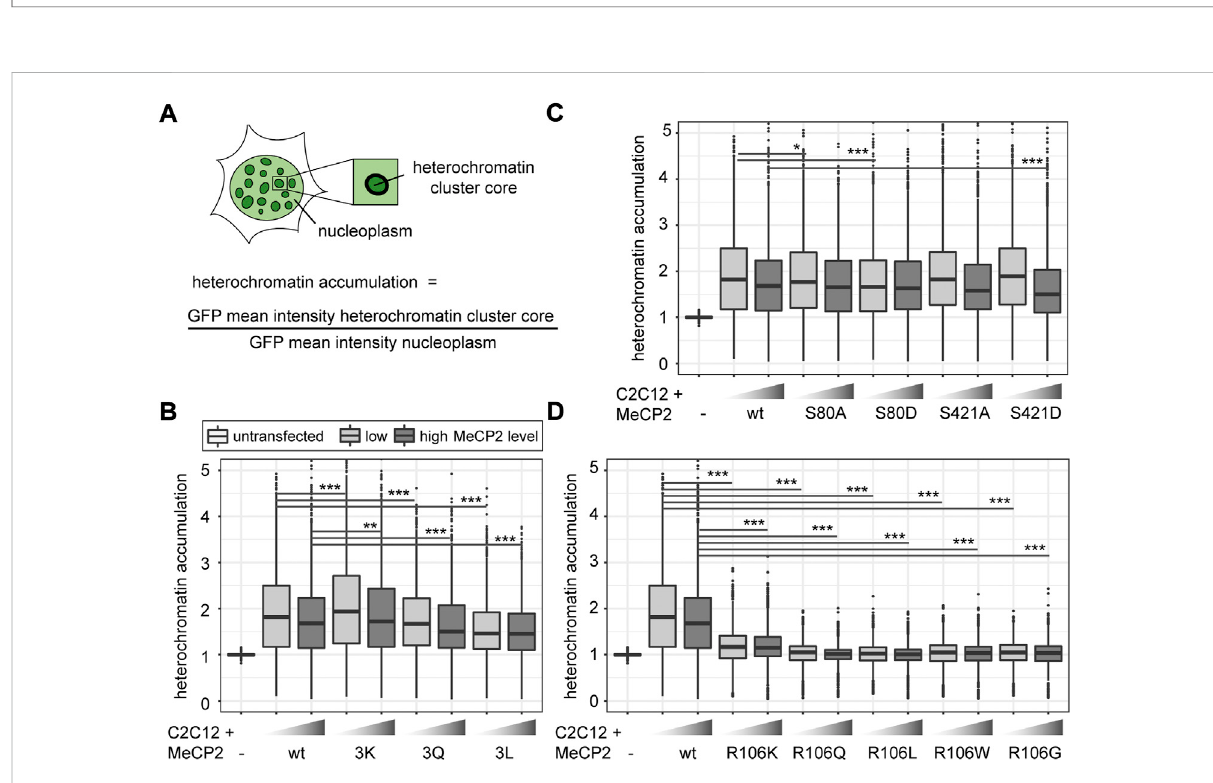
FIGURE 3 Comparative analysis of heterochromatin accumulation of MeCP2 mutant constructs transfected in C2C12 mouse myoblast cells. (A) Heterochromatin accumulation was calculated as the ratio of GFP mean intensity at heterochromatin versus nucleoplasm. The boxplots depict the heterochromatin accumulation of mutant MeCP2 including R91, R162, and R167 (B) , S80 and S421 (C) , and R106 (D) constructs for low and high MeCP2 levels in thecells. Three biological replicates, statistical signi fi cance calculated using Wilcoxon-Rank test. * p < 0.05, ** p < 0.005, *** p < 0.001. p -values and n-values are summarized in Supplementary Table